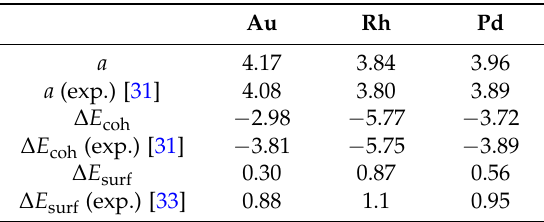
Table 1. Unit cell parameter a , cohesive energy ∆ E coh and surface energy ∆ E surf for the pure bulk metals, Au, Rh, and Pd (distances in Å, ∆ E coh in eV/atom, and ∆ E surf in eV/Å 2 ).